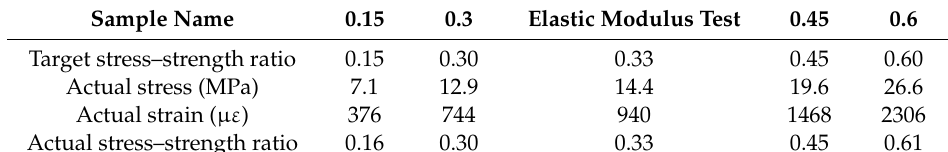
Table 6. The secant modulus under different stress–strength ratios.